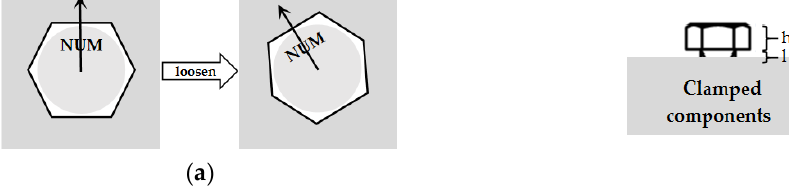
Figure 1. Two categories of bolt loosening detection. ( a ) Relative rotation recognition; ( b ) Relative length recognition.